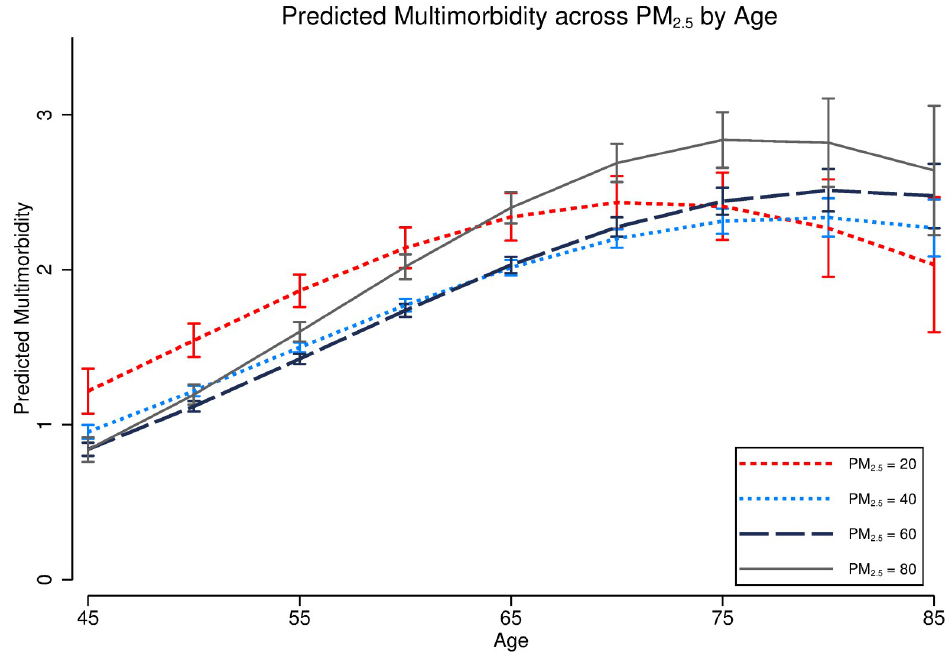
Fig 3. Predicted multimorbidity score across PM 2.5 exposure by age. Note that this model controls age, age squared, gender, education, HuKou-residence, occupations, marital status, smoking status, and logged GDP.